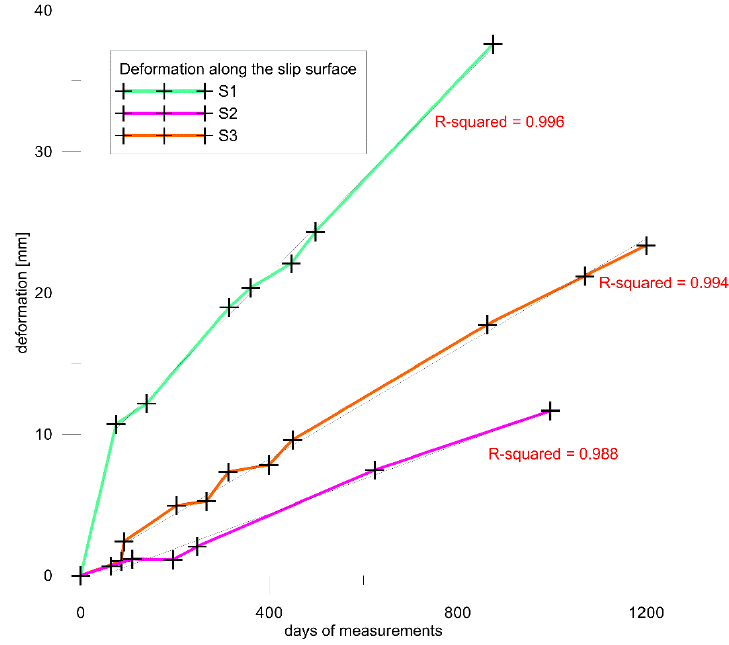
Figure 4. Trends of displacements along the slip surface for the three CNR-IRPI inclinometers.